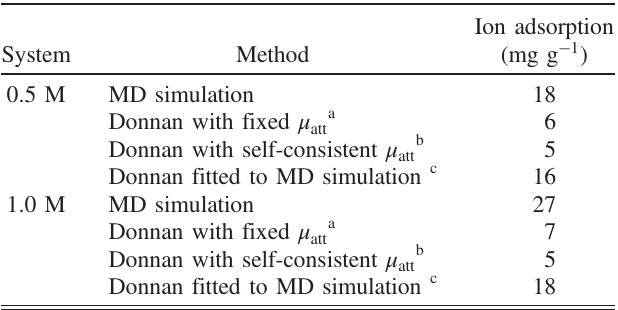
TABLE IV. Ionic concentration inside the electrode micropores for a symmetric electrochemical cell under a voltage of 1.0 V, from molecular dynamics simulations and from the modified Donnan model with various assumptions. Results are given as the total mass of ions inside both electrodes, per unit mass of both electrodes [see Eq.